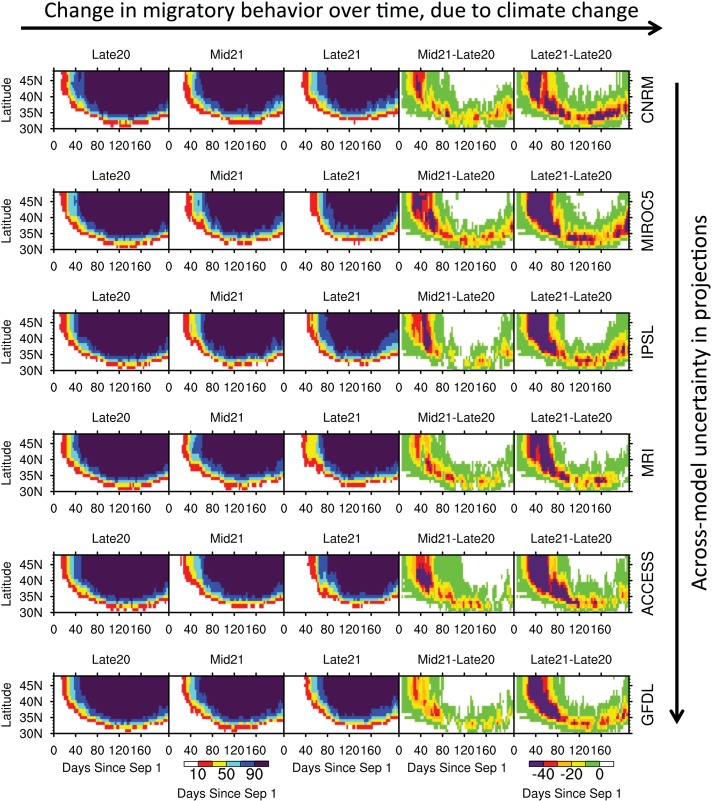
Same as Fig 5, but for the Northern Shoveler.